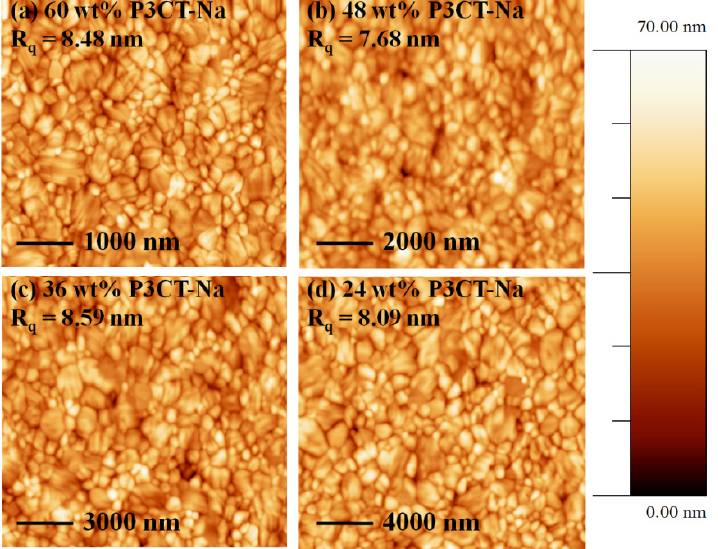
Figure 5. The atomic force microscopic images of the MAPbI 3 /P3CT-Na/ITO/glass samples: ( a ) 60 wt% P3CT-Na; ( b ) 48 wt% P3CT-Na; ( c ) 36 wt% P3CT-Na/; ( d ) 24 wt% P3CT-Na.